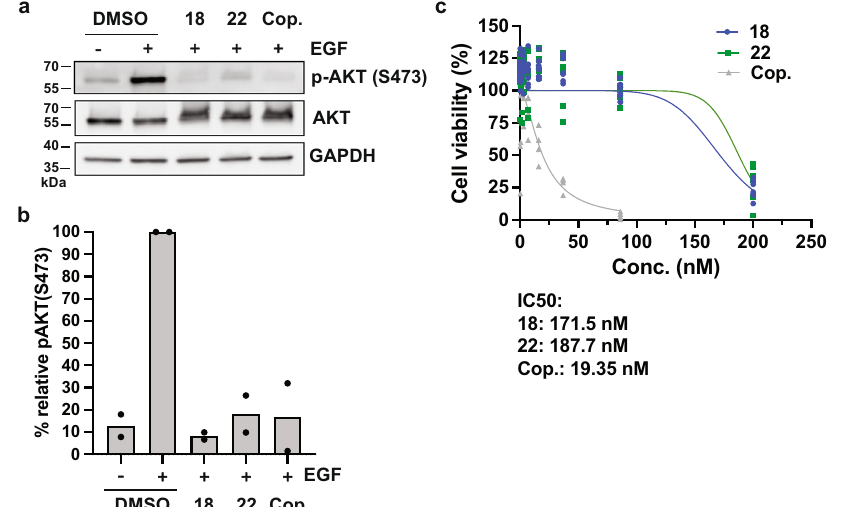
Fig. 6 | Compounds 18 and 22 repress PI3K-AKT signaling in tumor cells. a Representative immunoblot analysis p-AKT (S473), AKT, and GAPDH (loading control) using total lysates of human HD-MB03 tumor cells stimulated with 10ngml − 1 EGF for 15min in the absence or presence of compounds 18 or 22 , or copanlisib (Cop.). Compounds and copanlisib were used at100nM concentration. DMSOwasusedassolventcontrol. b Quanti fi cationofp-AKTlevelsrelativetoEGF-